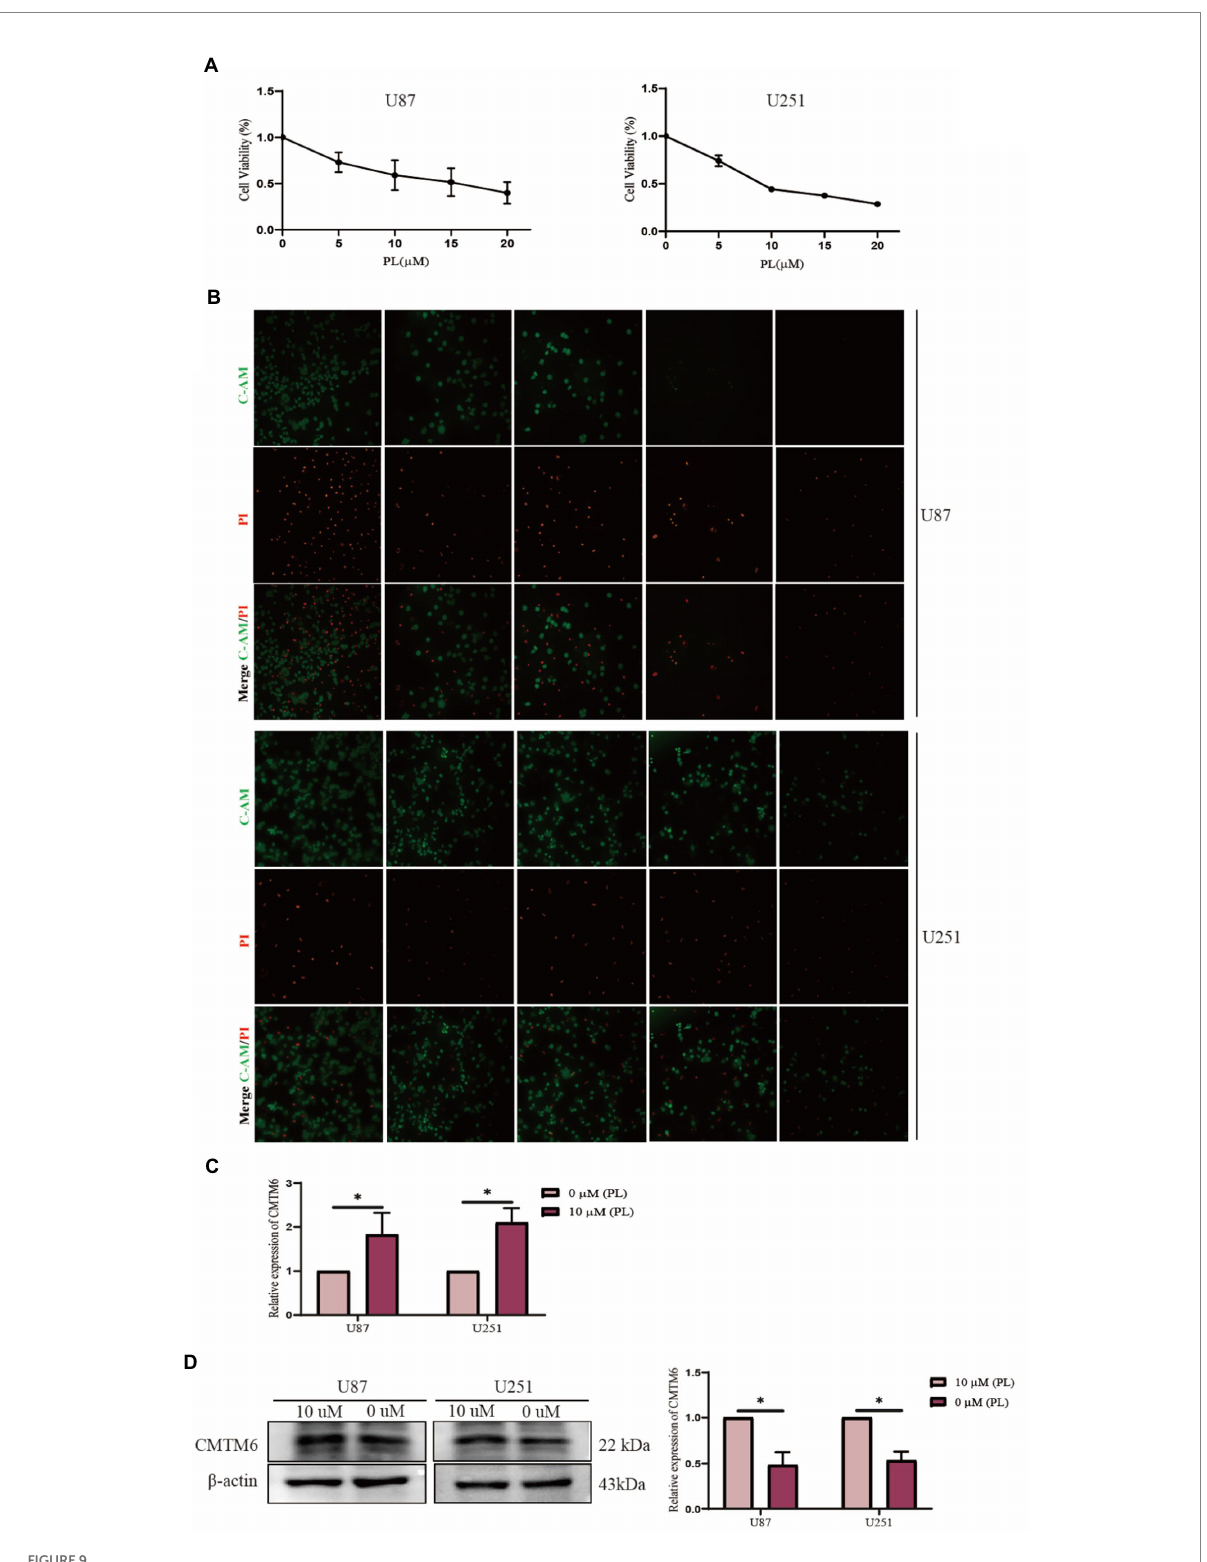
FIGURE 9 Piperlonguminine (PL) promotes the expression of CMTM6 in U87 cells. (A) CCK8 assay to detect the proliferation ability of U87 cells under the effect of different concentrations of PL at 0, 5, 10, 15, and 20 μ M. (B) Live-dead cell staining assay to detect the survival of U87 cells assay under the effect of different concentrations of PL at 0, 5, 10, 15, and 20 μ M. (C) qPCR assay to detect the change of CMTM6 mRNA level expression after 24 h of PL action on U87 cells. (D) Western blot plot and result analysis of CMTM6 protein levels after 24 h of PL action on U87 cells. * p <